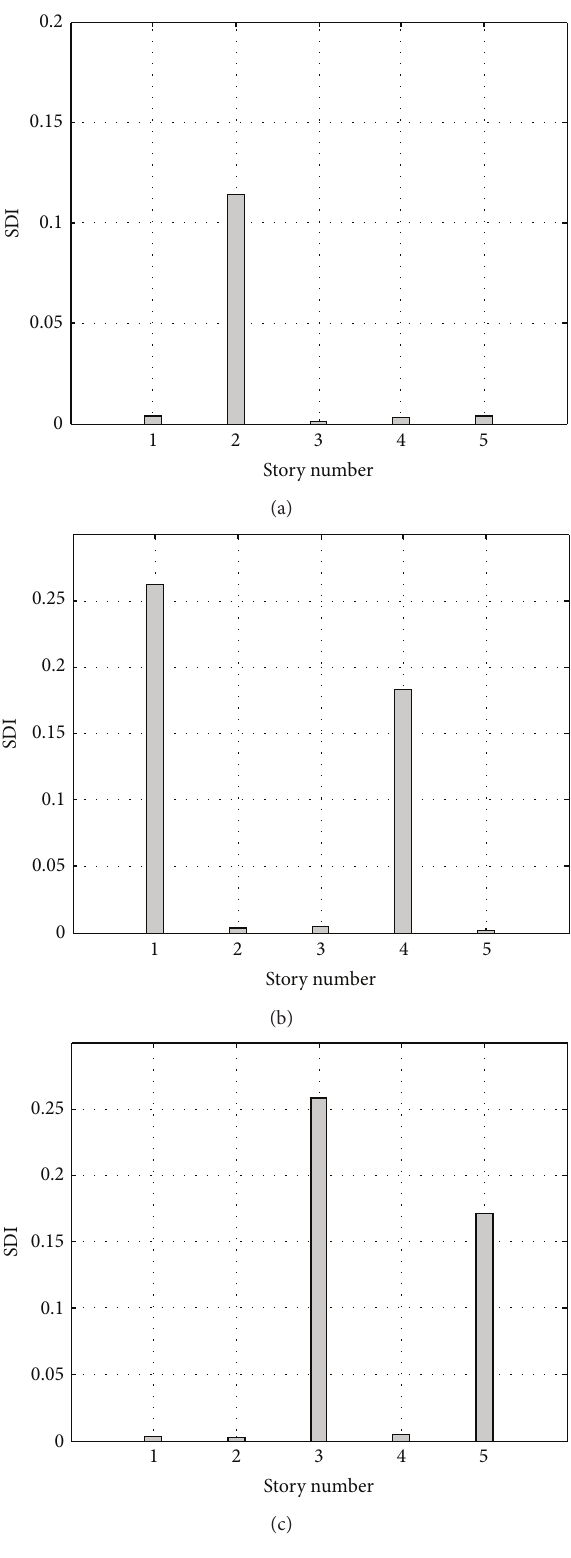
Figure 2: (a) Value of SDI in the five-story shear frame considering 2 modes for scenario I, (b) value of SDI in the five-story shear frame considering 2 modes for scenario II, and (c) value of SDI in the five- story shear frame considering 2 modes for scenario